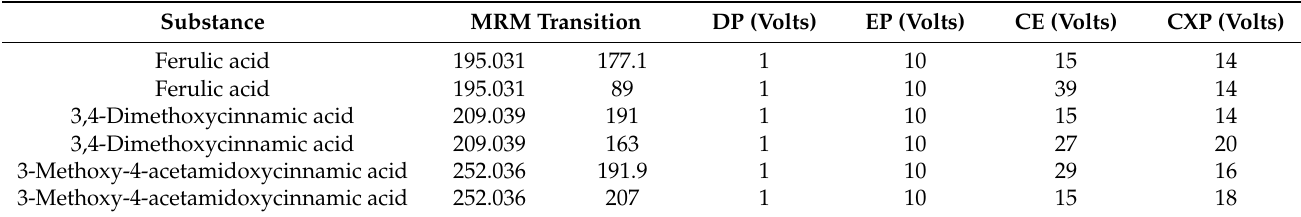
Table 1. Conditions for MRM transitions in the positive ion mode. Two MRM transitions are used for each substance for quantitative analysis and qualitative confirmation. Technical parameters for working with samples: DP—declustering potential, EP—entrance potential, CE—collision energy, CXP—collision cell exit